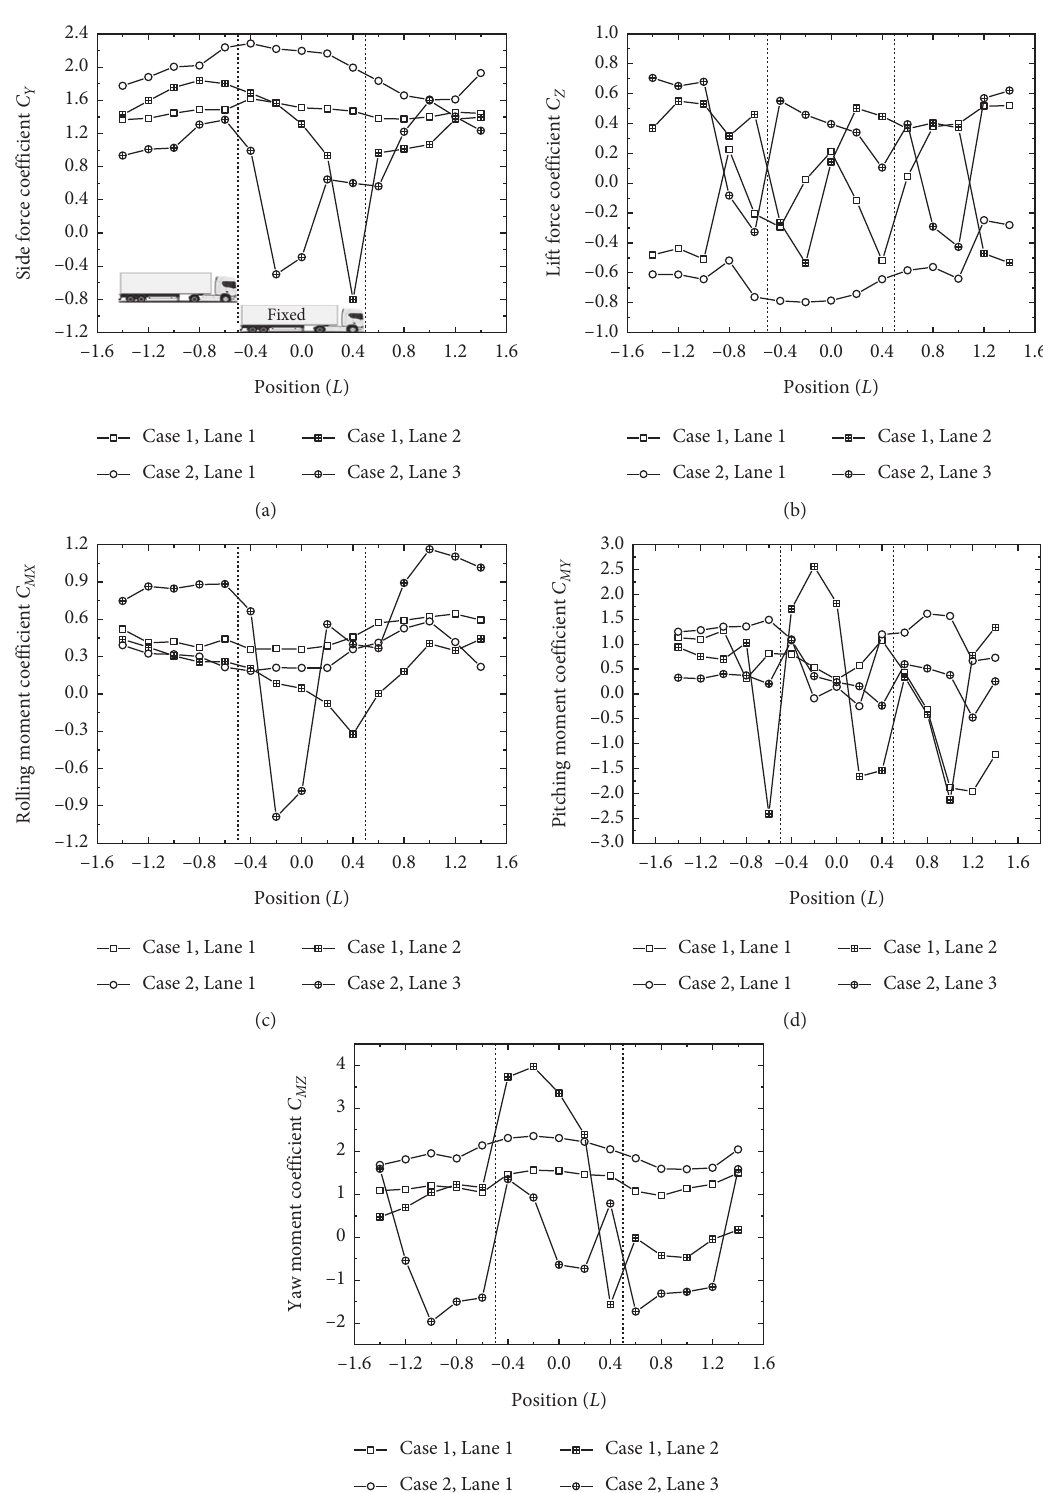
Figure 6: 3s peak aerodynamic coefficient of the (Figures 7(a) and 7(d)) and rolling moment coefficients (Figures 7(c) and 7(f)) in Case 3 are greater than those of Case 4 as vehicles move in the first lane, yet the lift coefficient